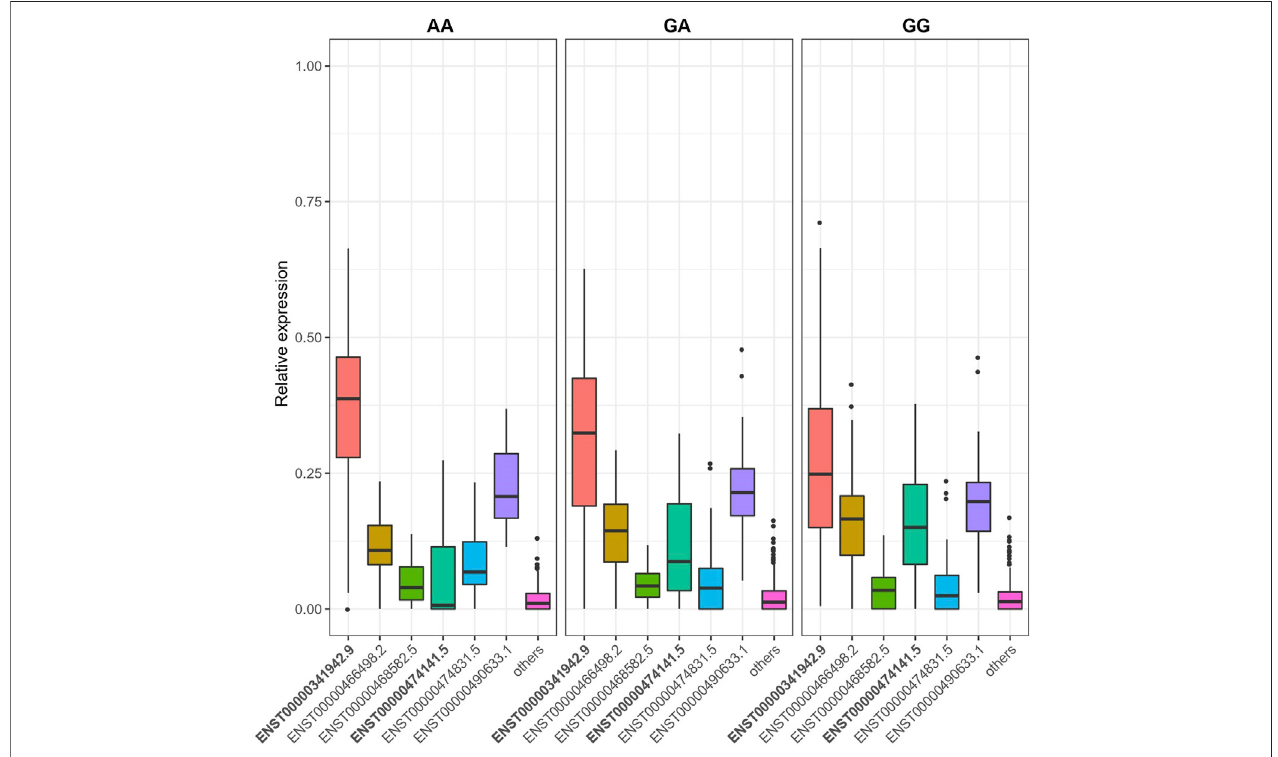
FIGURE4| SNPrs10231604regulatestheexpressionof LAMTOR4 transcripts.RelativeexpressionoftranscriptENST00000341942.9decreaseswithincreasing dosage of the wildtype allele (G). Relative expression of transcript ENST00000474141.5 increases with increasing dosage of the wildtype allele (G).